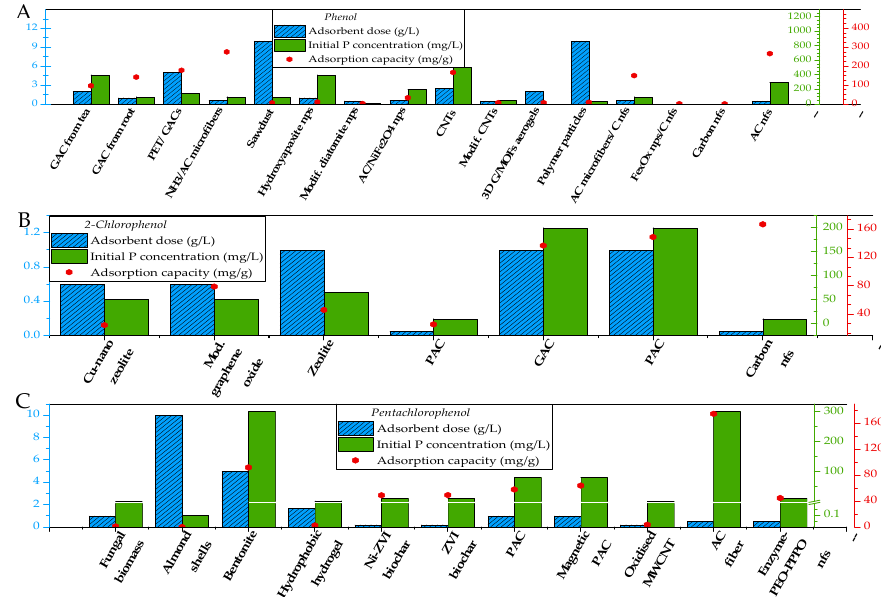
Figure 9. Relationship between adsorbent dose (blue column, left scale), initial pesticide concentration (green column, middle right scale) and adsorption capacity (red scatter, far left scale) in the adsorption of Phenol ( A ); 2-Chlorophenol ( B ) and Pentachlorophenol ( C ).